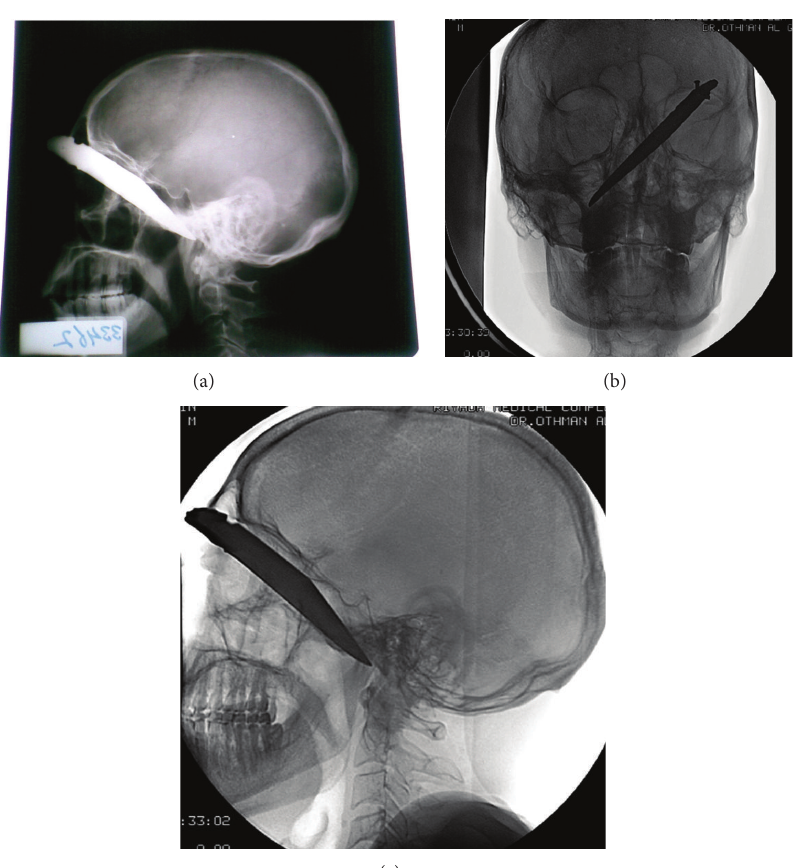
Figure 2: ((a), (b), and (c)) Radiographic images describing the route of the knife and the tip reaching the infratemporal region across the